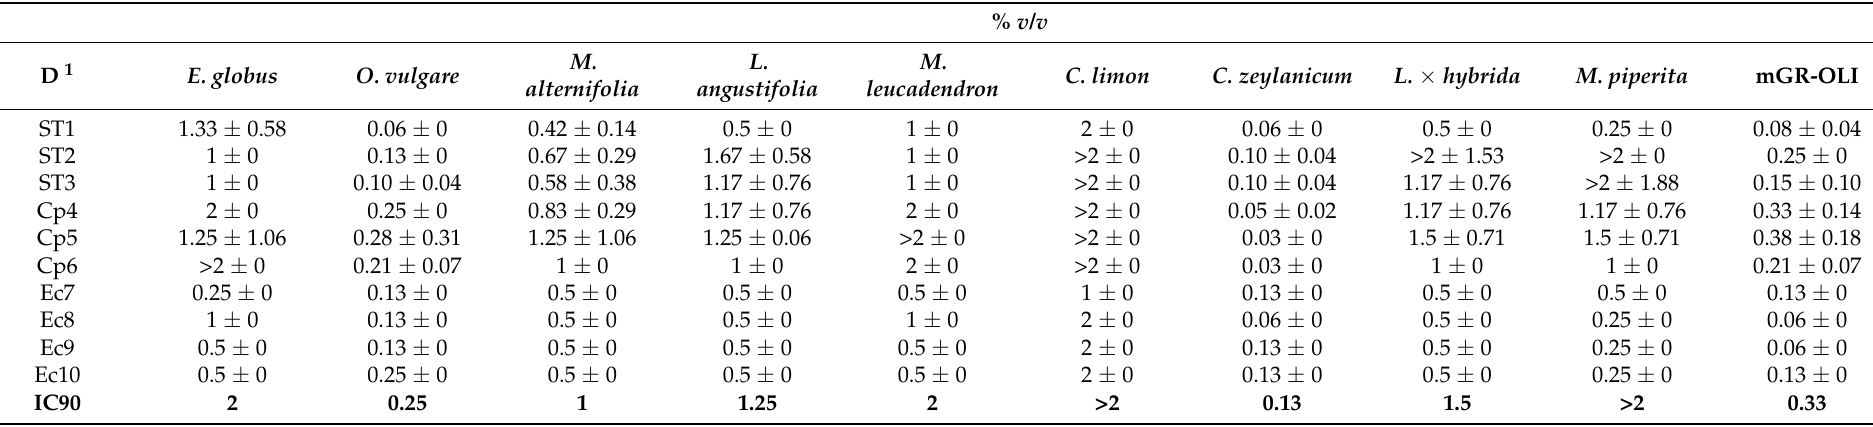
Table 4. Susceptibility testing against natural products: MIC (% v / v